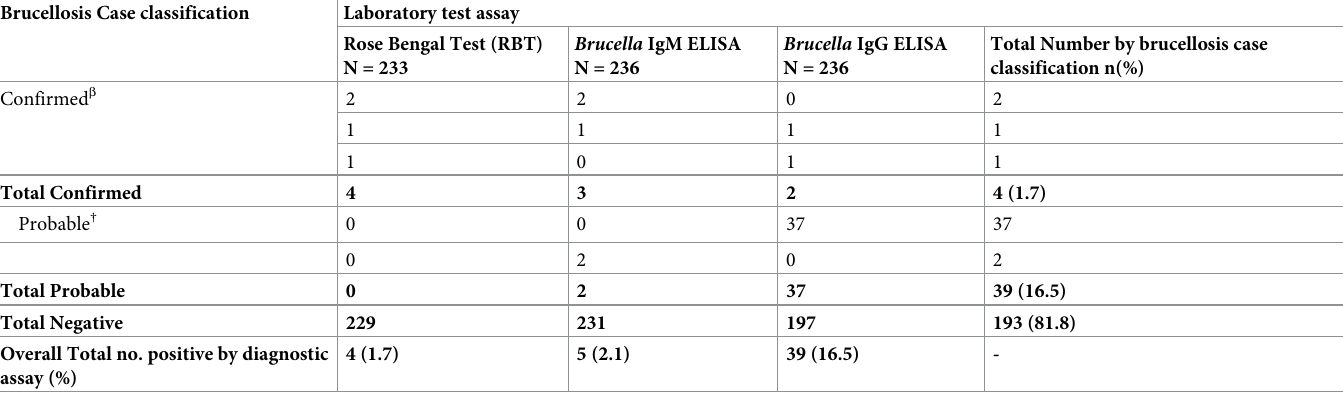
Table 2. Distribution of laboratory test results by brucellosis test assay for febrile cases, Kajiado 2015–2016 (n = 236). Brucellosis Case classification